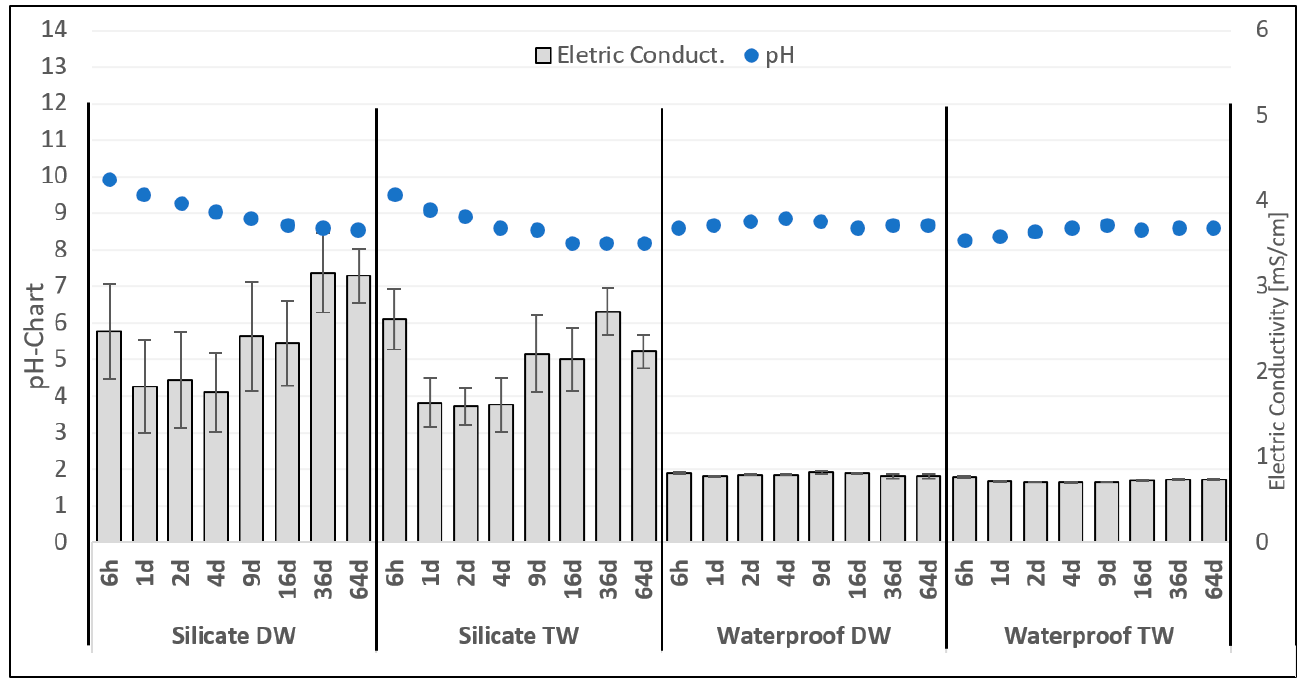
Figure 2. Graphic representation of pH and electric conductivity. Values are measured for all eluates of silicate and waterproof products.